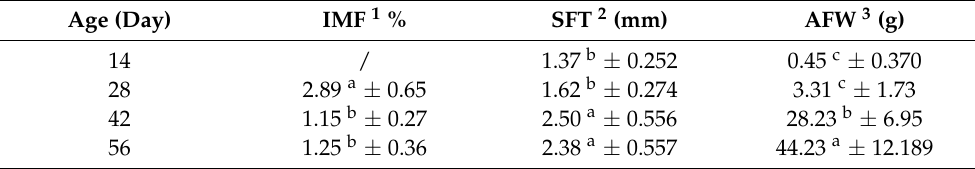
Table 1. Fat deposition of Muscovy duck at different